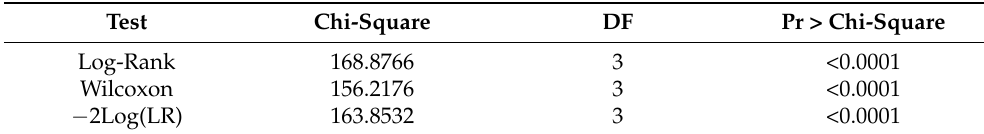
Table 4. Testing Homogeneity of Survival Curves.